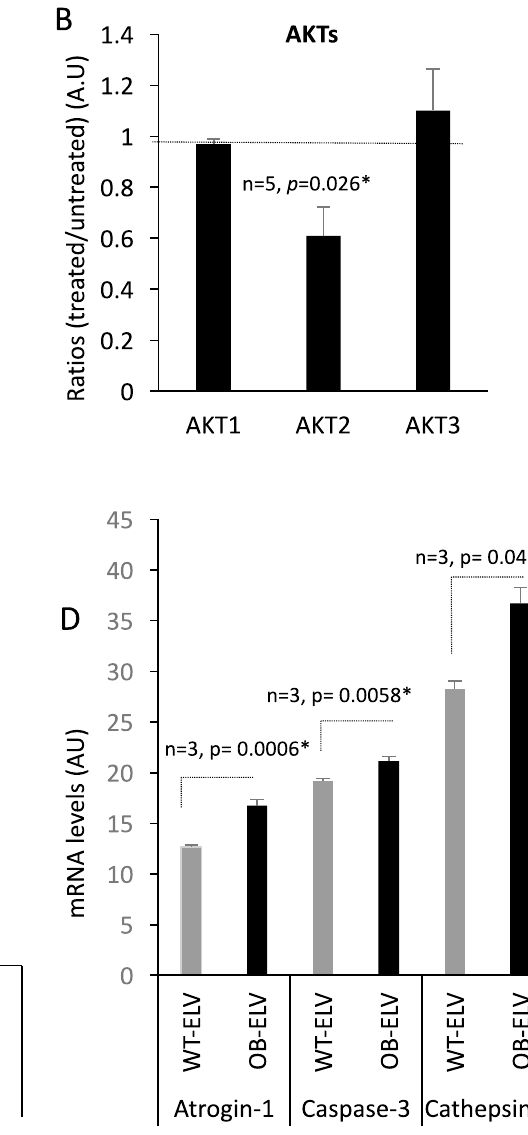
Figure 7. OB-ELVs induced insulin-resistance and atrophy in recipient muscle cells. ( A ) Quantification of phosphorylated AKT protein on serine serine A-473 by Western-blot in C2C12 treated with SkM-ELVs. Data are expressed in fold p-AKT/total AKT. ( B ) Quantification of AKT isoforms in C2C12 treated with SkM-ELVs by WB. Data are expressed as ratios of AKT level in treated vs untreated conditions. ( C ) mRNA levels of genes involved in insulin-stimulated glucose uptake. Data are expressed as arbitrary units. ( D ) mRNA level of genes involved in muscle atrophy. Data are expressed as arbitrary